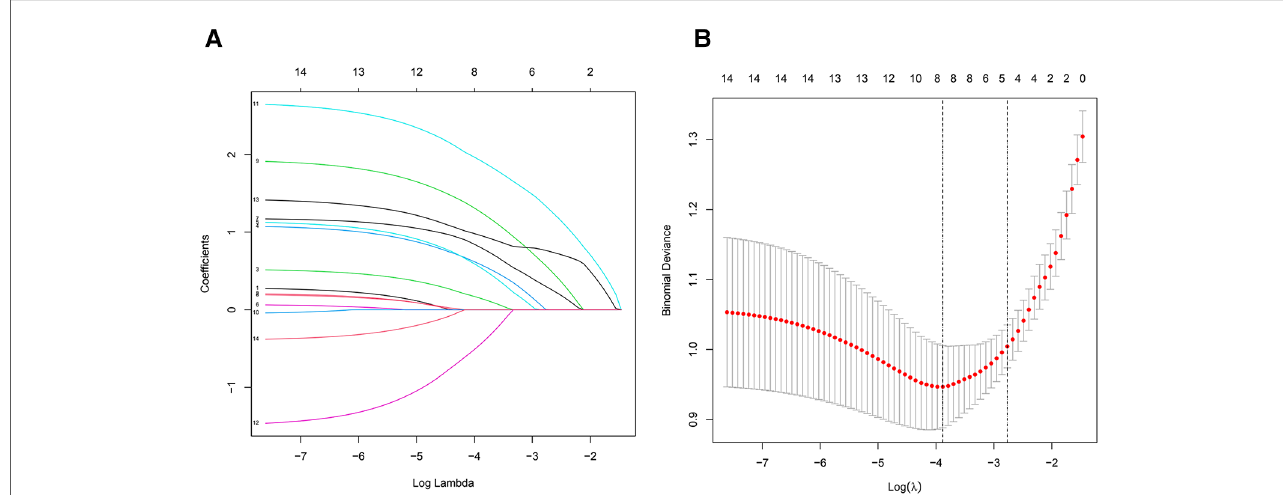
FIGURE 2 ( A ) All parameters were included in the LASSO analysis, and coef fi cient pro fi les were plotted for 14 features using the LASSO binary logistic regression model. ( B ) All parameters were included in the LASSO analysis. Binomial deviations were plotted using the LASSO binary logistic regression model, with eight parameters being statistically signi fi cant.